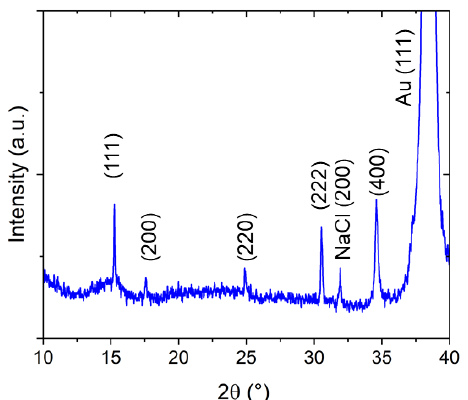
Figure 3. X-ray diffraction pattern of NaFeHCF film grown at ~0.3 V measured with Cu K α Figure 3. X-ra y diffraction pattern of NaFeHCF film grown at ~0.3 V measured with Cu Kα radia- tion.